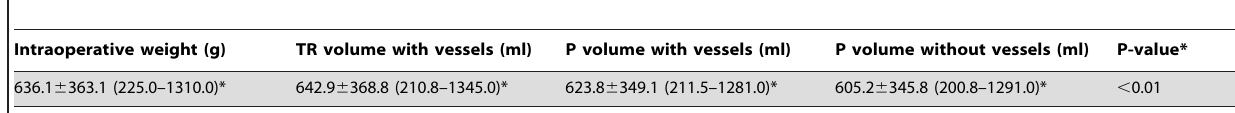
Table 2. Intraoperative Weights and Volumes of Transplanted Liver Segments.